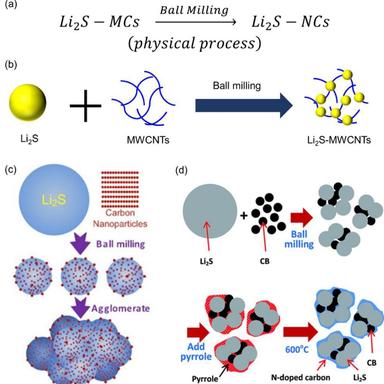
The equation (a) and schematic illustrating different methods (b–d) of making Li2S-C composite materials via ball milling commercial Li2S-MCs. (b) Li2S-MWCNTs; (c) Li2S-CB; and (d) Li2S@HC . Reproduced from Refs. with permission from the American Chemical Society and Royal Society of Chemistry.